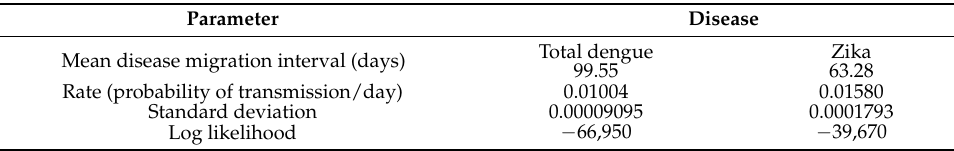
Table 1. Fitted disease migration interval distribution parameters.